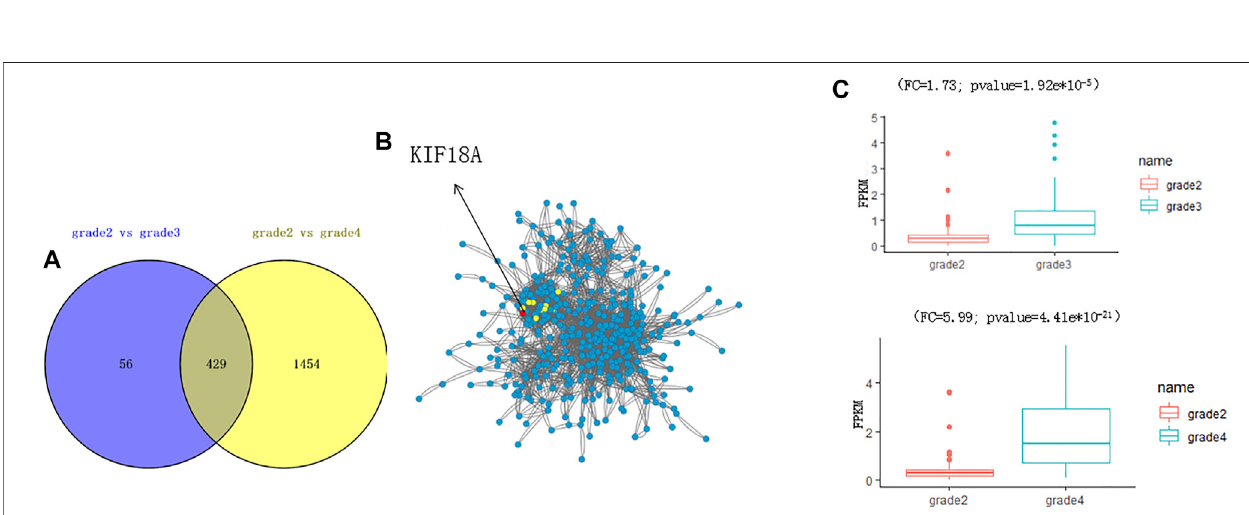
FIGURE 2 | Identi fi cation of KIF18A as a potential gene to affect the progression of glioma. (A) The plot shows the overlapping DEGs. (B) The network analysis shows theinteraction of429DEGs.Theredcircleshowsthetop fi vehub genesinthenetwork,including KIF18A . (C) Theboxplotshowstheexpression levelof KIF18A .